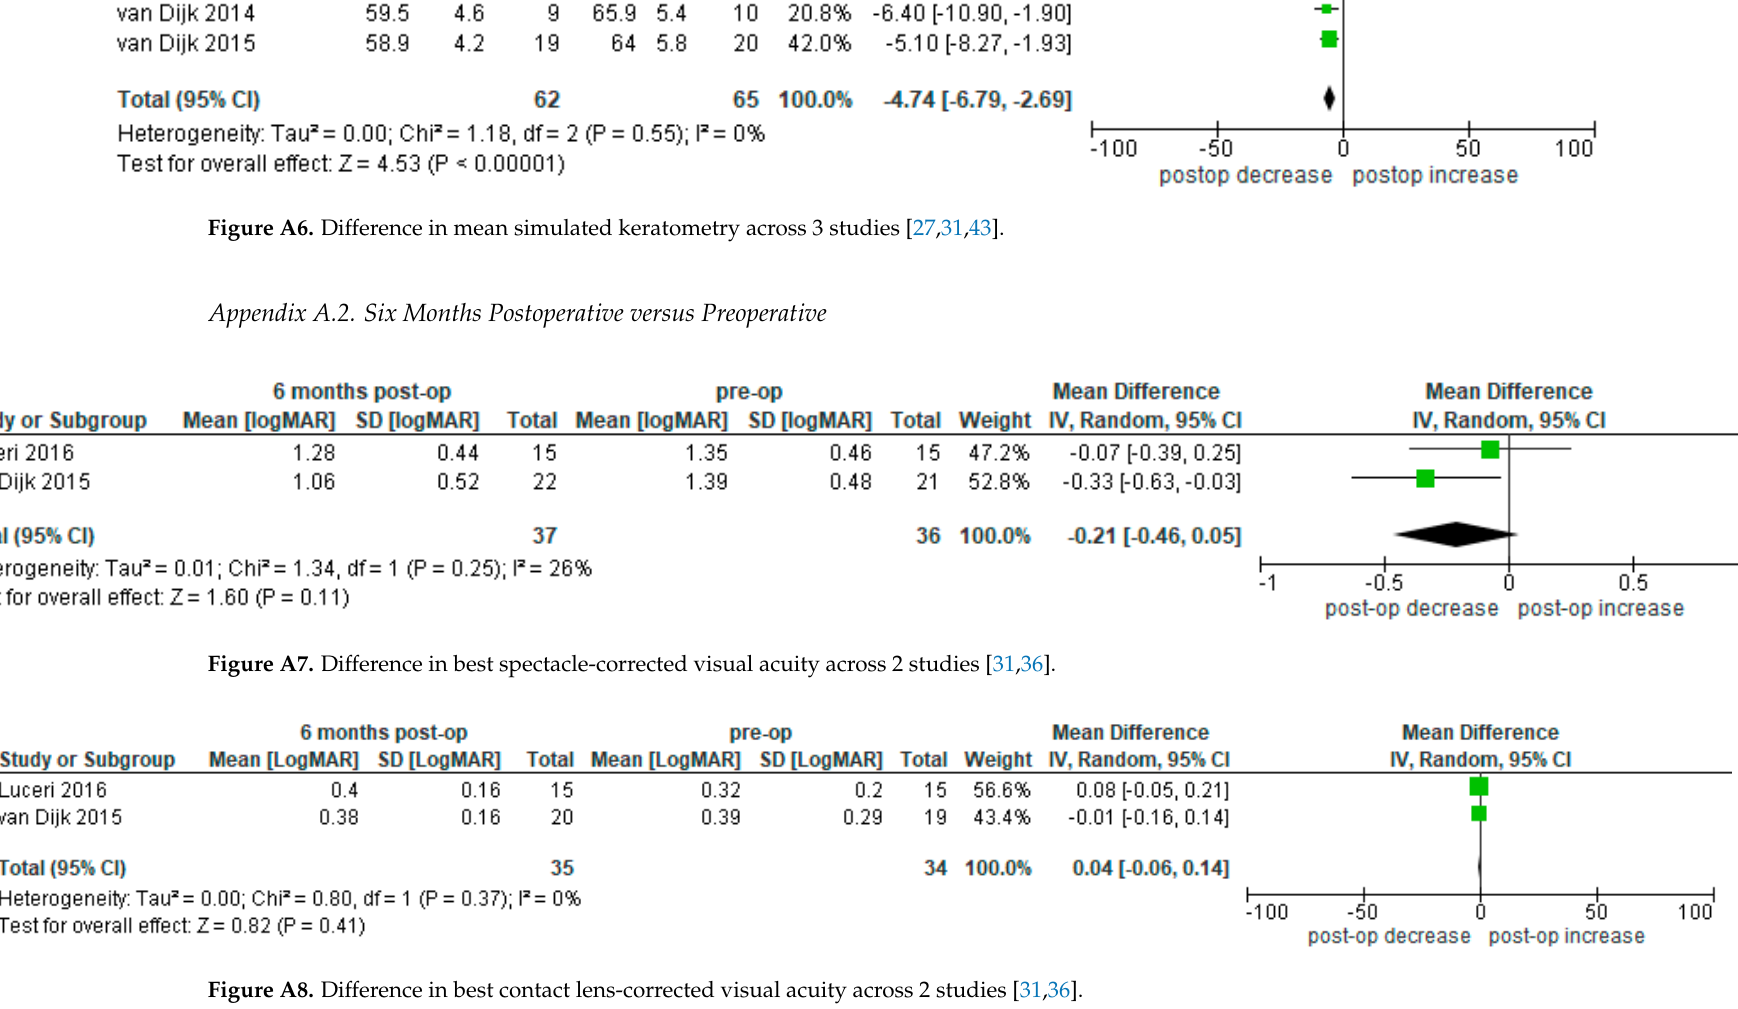
Figure A9. Di ff erence in pachymetry thinnest point in 1 study [31].